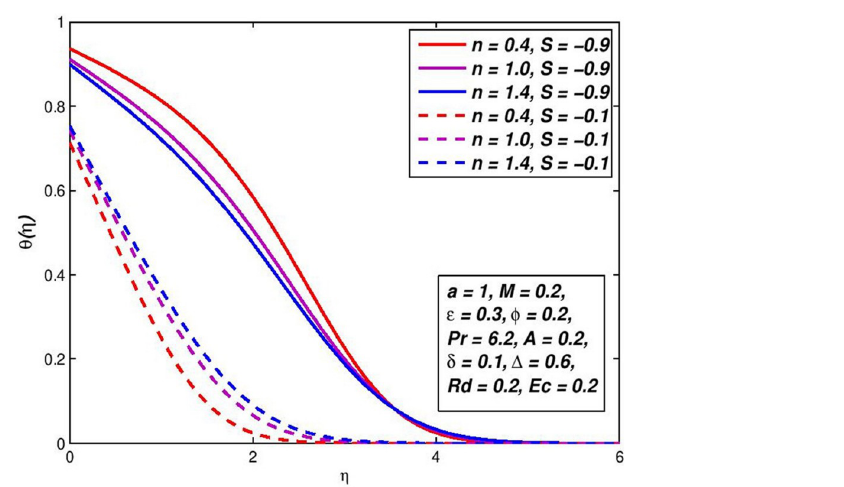
Fig 17. Effect of S < 0 on θ ( η ) for diverse n values.